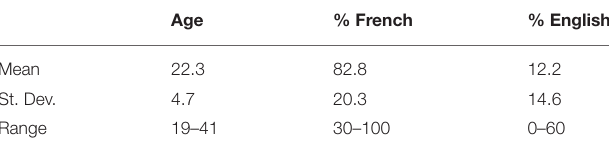
TABLE 2 | Native French speakers.